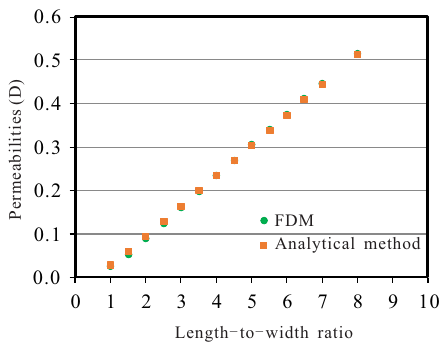
Figure 13. Comparison between the permeabilities calculated by IFDM and by the analytical method for the rectangular tube models with different length-to-width ratios. The width of a cross section is constant and its value is 8 μ m.